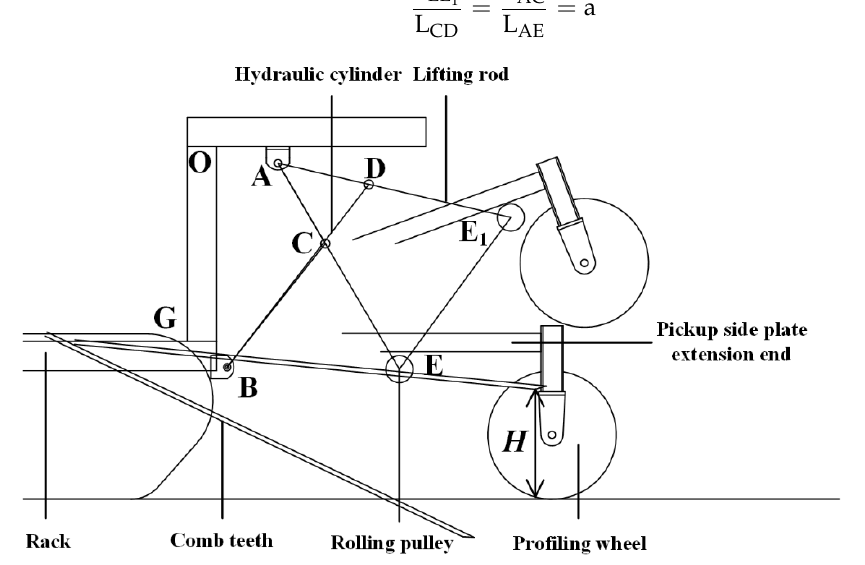
Figure 3. Schematic diagram of lifting principle.